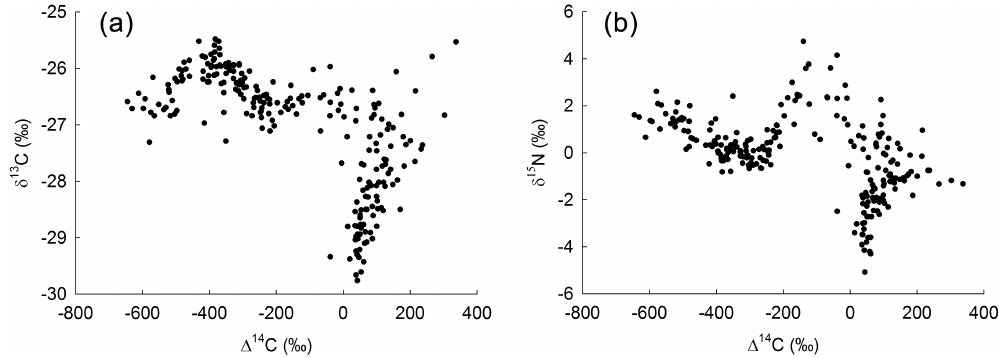
Figure 6. Relationship between (cid:49) 14 C and (a) δ 13 C; (b) δ 15 N.